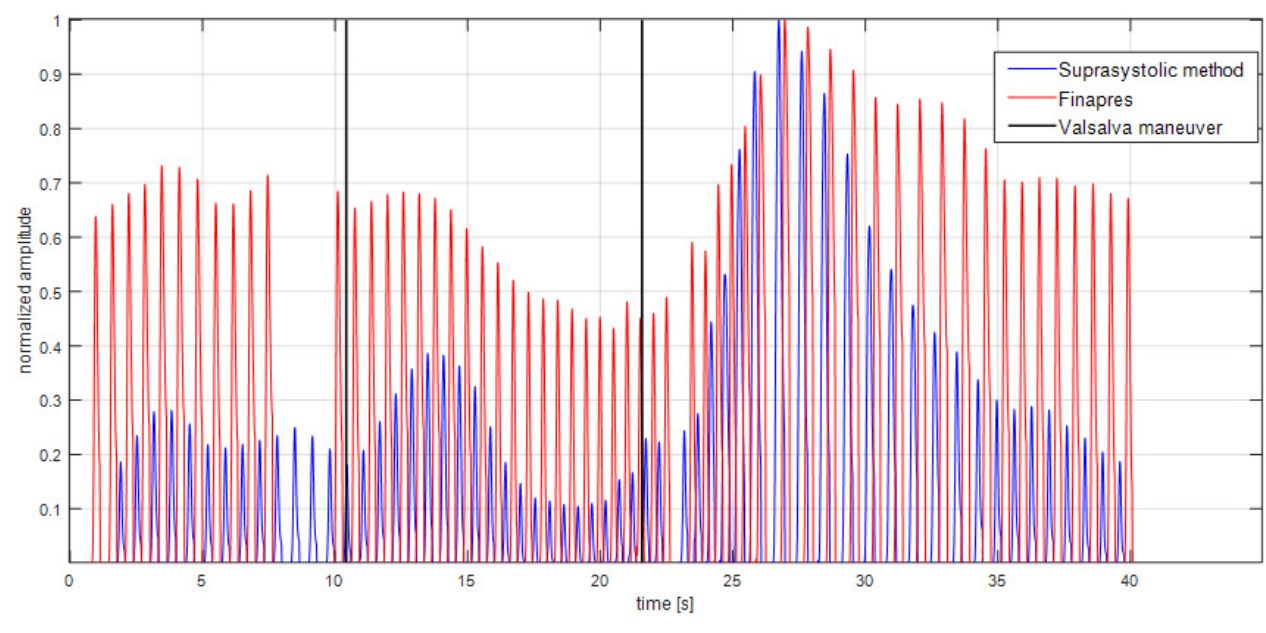
Figure 2. The example of signal processing of both signals described in the signal processing section. Normalized amplitude to see the changes caused by the Valsalva maneuver. Use of the Fisher’s Z-transformation and averaged Pearson’s correlation coefficient to confirm the hypothesis about similarities between measured pulse waves ( r = 0.6, p < 0.001).